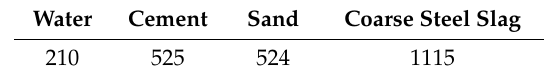
Table 1. Mix proportion of the concrete (by weight kg/m 3